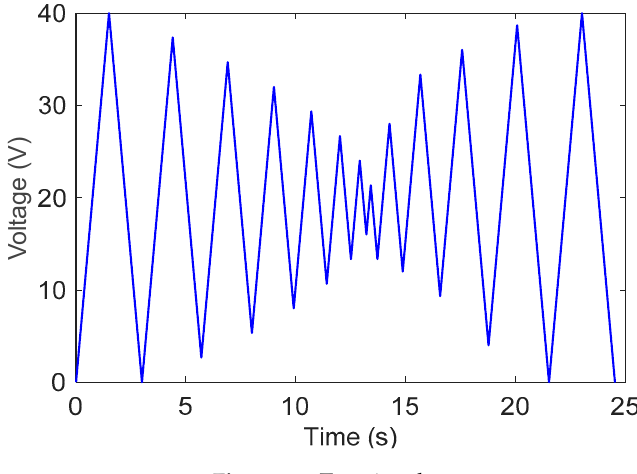
Figure 12. Test Figure 12. Test signal.